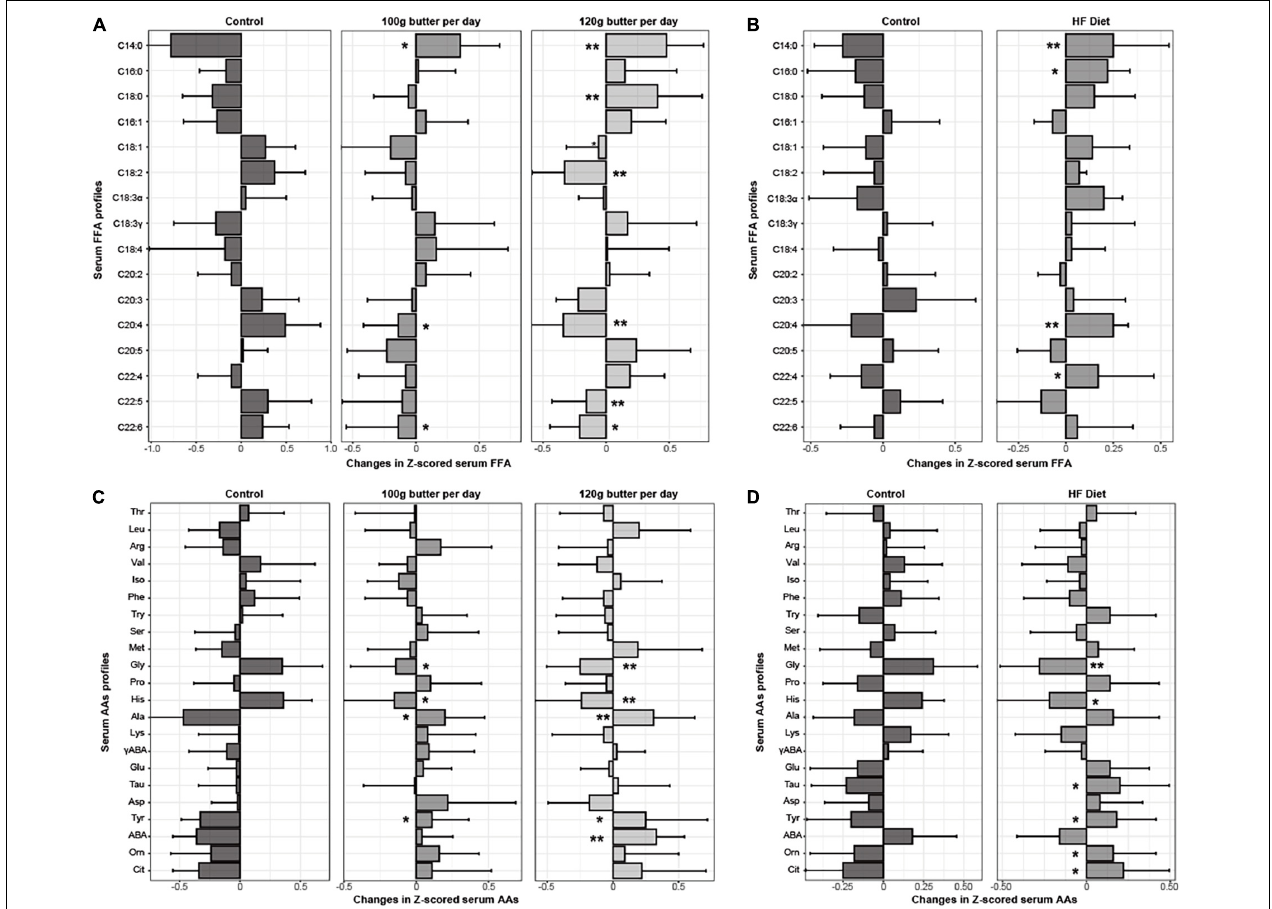
FIGURE 1 | Changes in Z -scored profiles of serum fatty acids and amino acids in the two RCTs. * p < 0.05 for the differences in the Z -scored serum fatty acids and amino acids between the intervention group and control group. ** p < 0.01 for the differences in the Z -scored serum fatty acids and amino acids between the intervention group and control group. (A) Changes in the Z -scored profiles of fatty acids in the RCT1. (B) Changes in the Z -scored profiles of fatty acids in the RCT2. (C) Changes in the Z -scored profiles of amino acids in the RCT1. (D) Changes in the Z -scored profiles of amino acids in the RCT2.